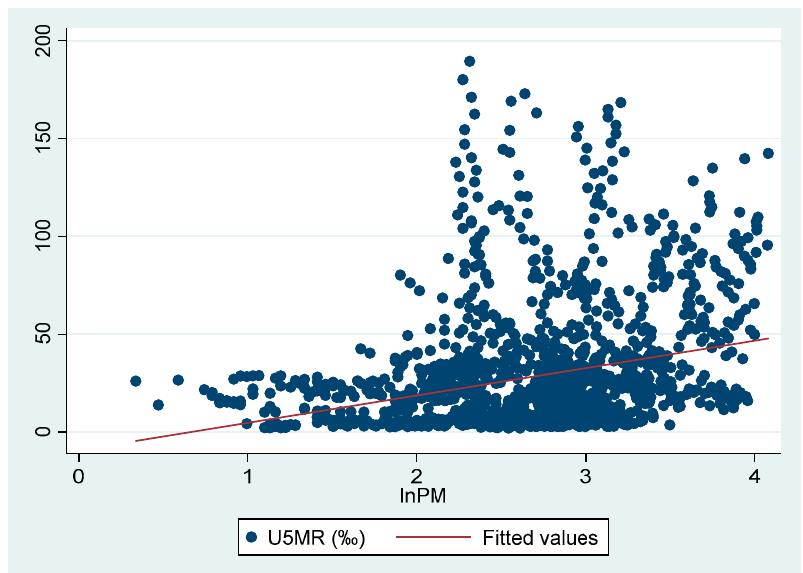
Figure 2. Fine particulate air pollution and U5MR.